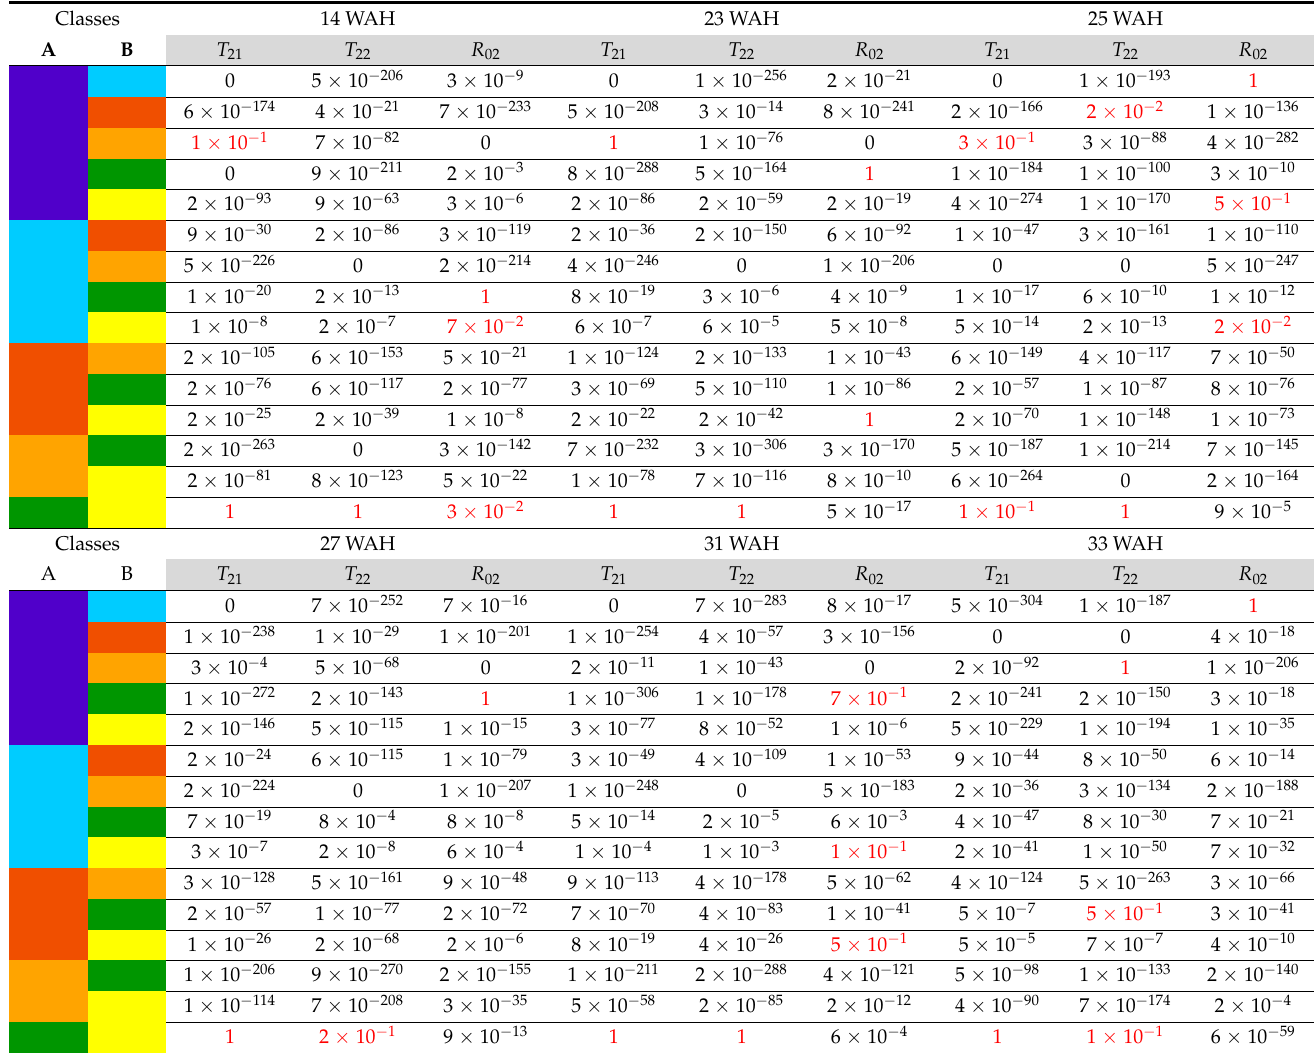
Table 1. p -values for each pair of classes and each variable for 14, 23, 25, 27, 31 and 33 WAH. Values >0.01 are shown in red. Colors were attributed regarding both T 22 and spatial information as detailed in the text. On average, purple could be attributed to cortex, green to the pith and yellow to the defects, the three other colors, light and dark orange and cyan, to the